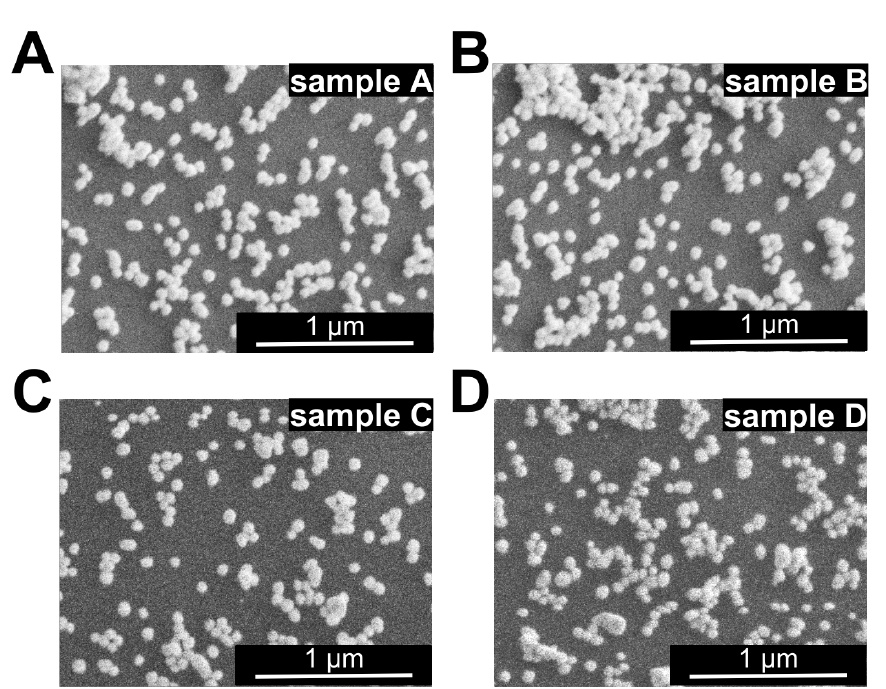
Figure A7. SEM images of the four identical samples of gold nanoparticles covering the optical fiber